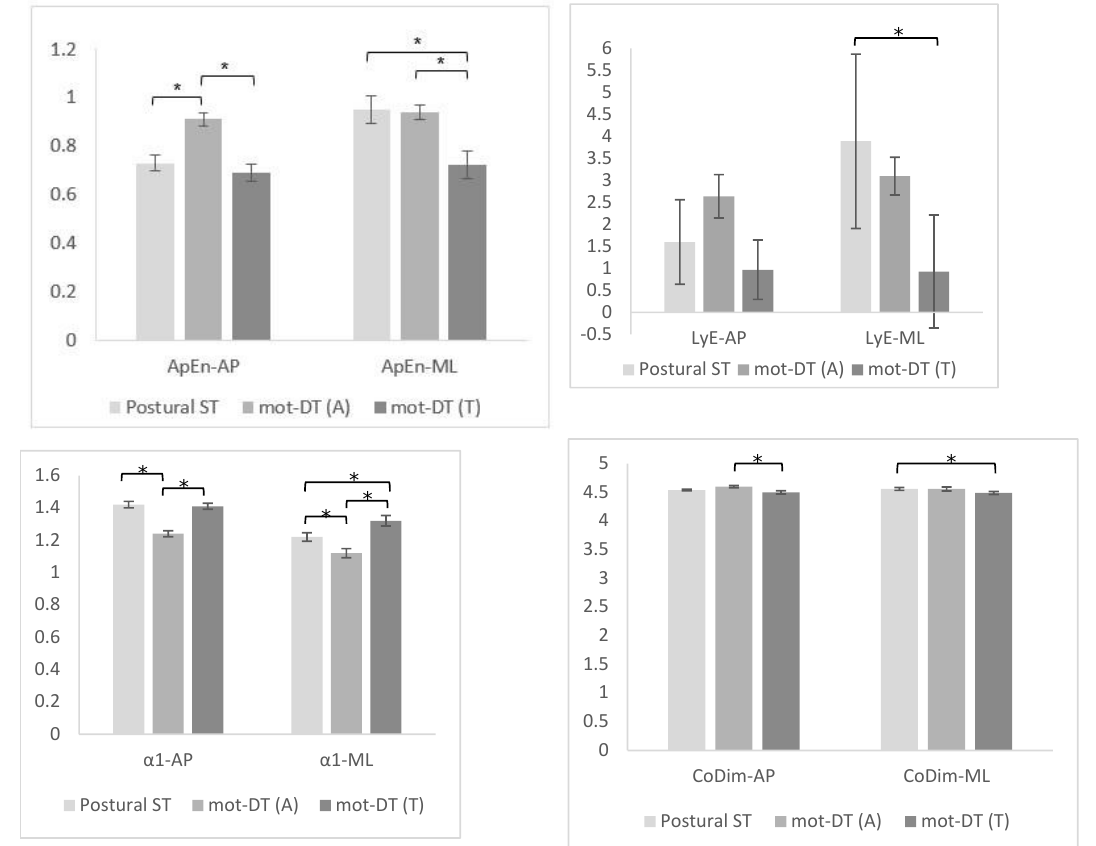
Figure 2. Comparisons between postural single task (ST) and easy and difficult motor dual tasks: CoP nonlinear analysis. ST, single task; Mot-DT (A), easy motor dual task; Mot-DT (T), difficult motor dual task; ApEn, approximate entropy; LyE, Lyapunov exponent; α 1, detrending fluctuation analysis (short-term); CoDim, correlation dimension, AP, anterior-posterior; ML, mediolateral. The y−axis displays the median values of the nonlinear measures, and the error bars, the standard error. * p < 0.05: Friedman test with Bonferroni correction for multiple comparisons. Table 2. Comparisons of CoP time series displacements among postural single task and easy and difficult motor dual tasks, median (IQR).